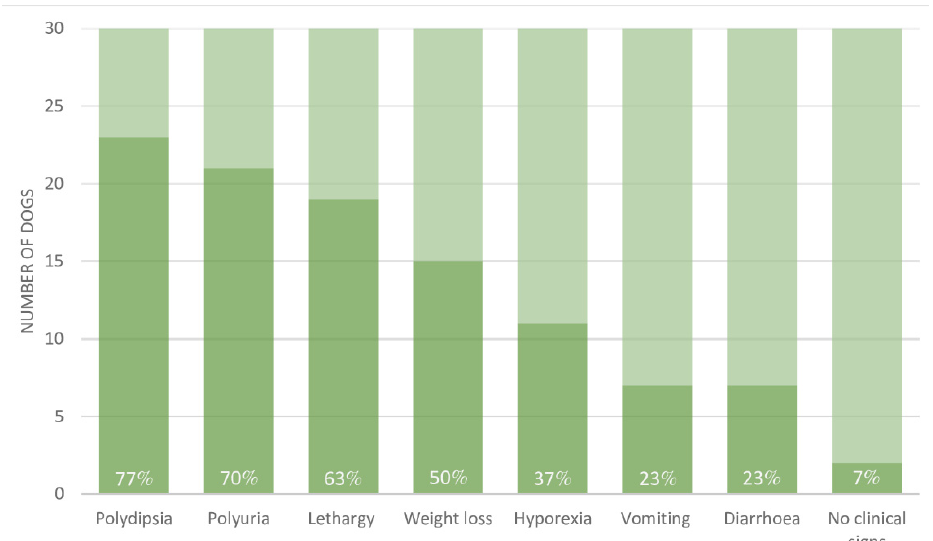
Figure 2. Clinical signs in 30 dogs diagnosed with jerky induced Fanconi syndrome. The dark portion of each bar represent the proportion of dogs reported to display the clinical sign in question out of the 30 dogs included (the total height of each bar). The prevalence for each clinical sign is indicated in percentage as well.